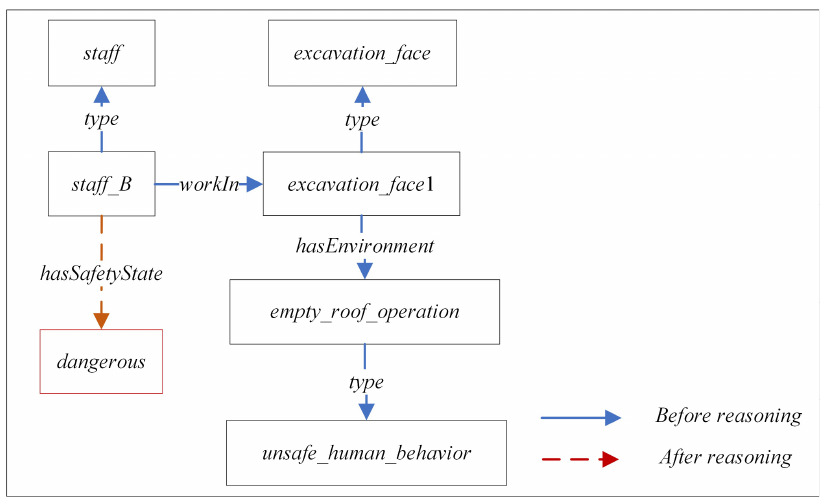
Figure 12. The reasoning chain to judge the personnel risk.